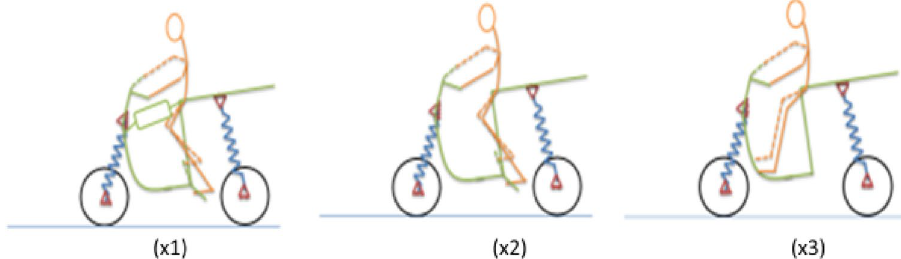
Figure 4. Broad two-wheeler classification based on access.